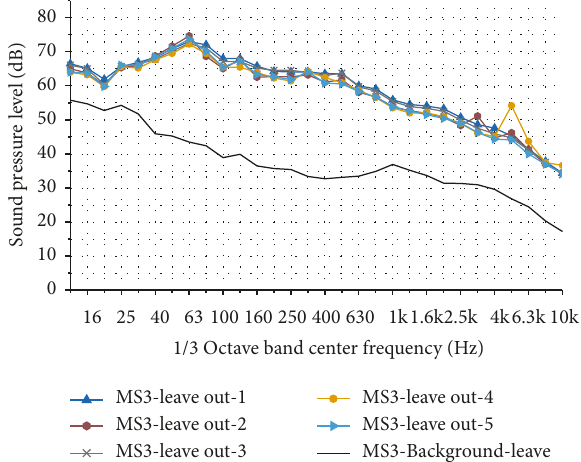
Figure 13: 1/3 octave frequency spectrum for measurement points MR2.